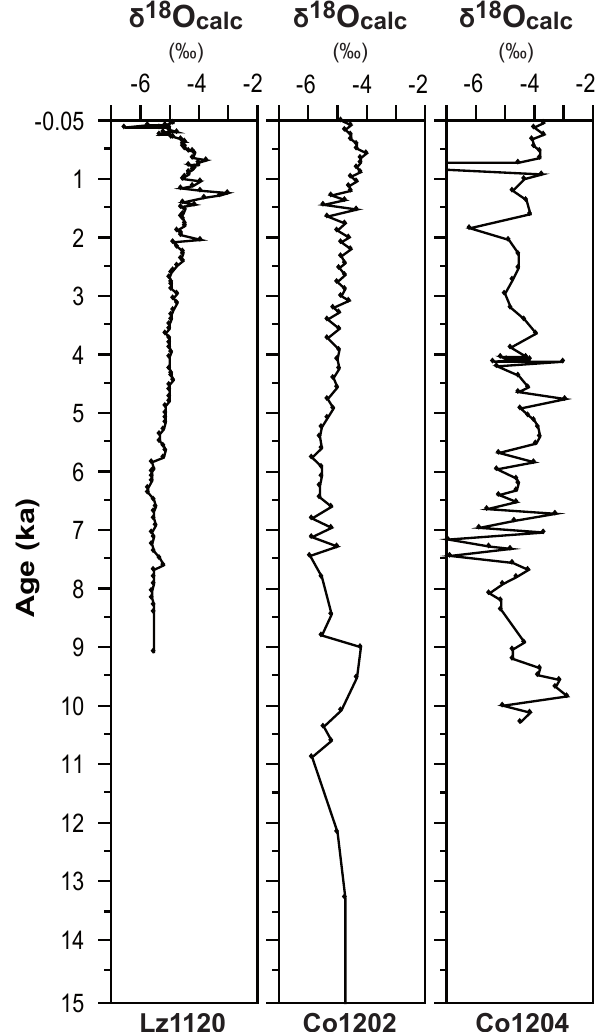
Fig. 7. Comparison of δ 18 O of authigenic calcite in cores Lz1120, Co1202 (Lake Ohrid) and Co1204